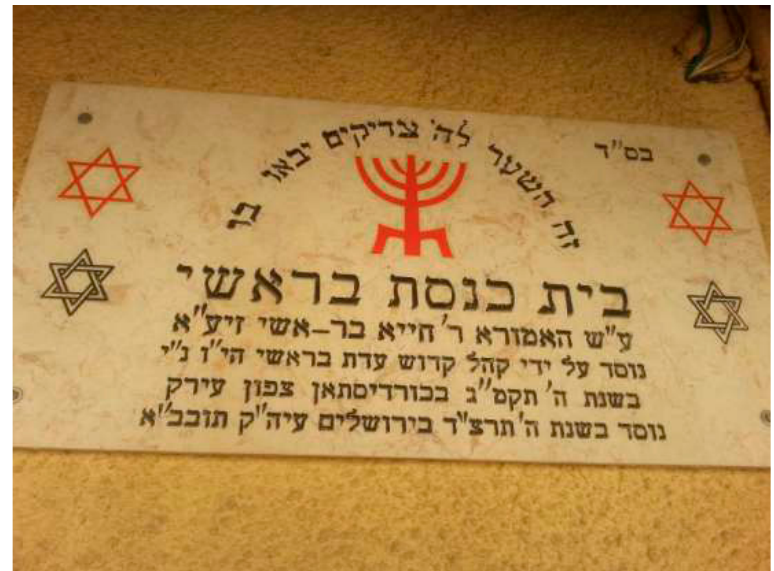
Figure 1. Panel in front of the Navi Yehezkel ( לאקזחי איבנ ) synagogue in Jerusalem (photo: Rafi Kfir, 2015).